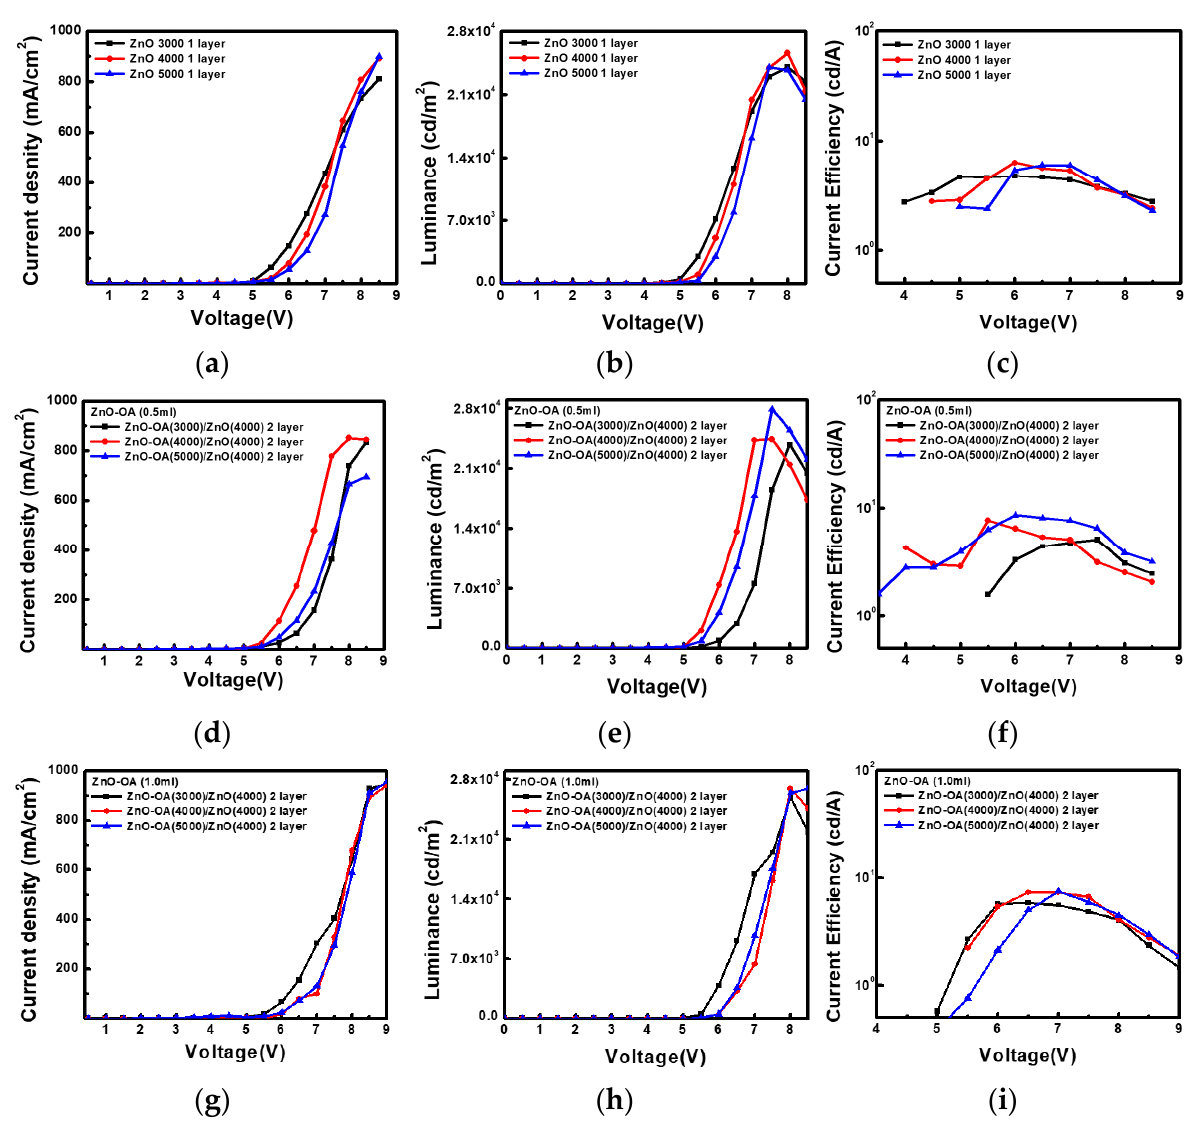
Figure 13. ( a , d , g ) current density (J)-voltage (V), ( b , e , h ) Luminance (L)-Voltage (V), and ( c , f , i ) Current efficiency-voltage (V) for QLEDs with a single ZnO QDs ETL and ZnO-OA (0.5 mL)/ZnO, and ZnO-OA (1.0 mL)/ZnO double ETLs respectively.